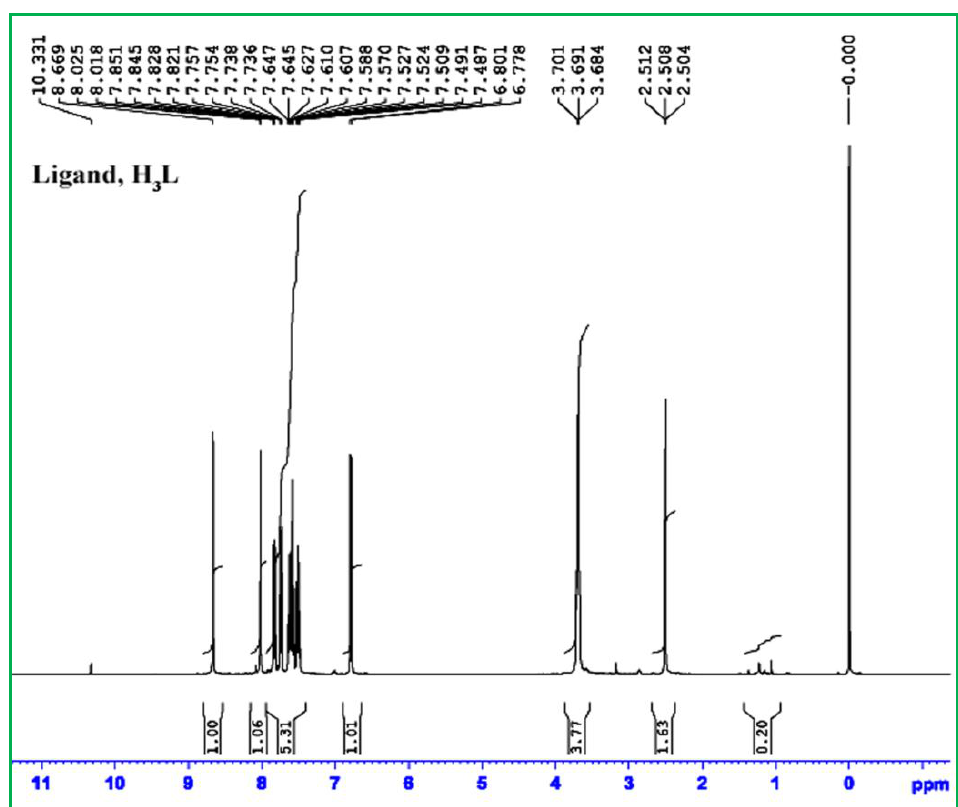
Figure 1. 1 H NMR spectrum of the Ligand, H 3 L.